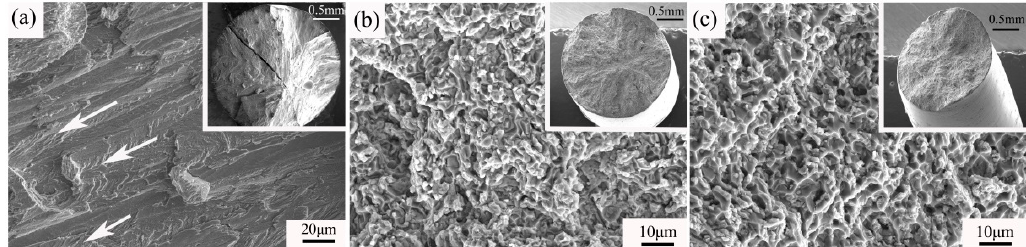
Figure 4. The microscopic fracture morphologies for alloys ( a ) Al 83 Cu 17 , ( b ) Al 90 Cu 10 and ( c ) Al 94 Cu 6 are shown. The insets in ( a–c ) show the macroscopic fracture surfaces of the corresponding alloys.